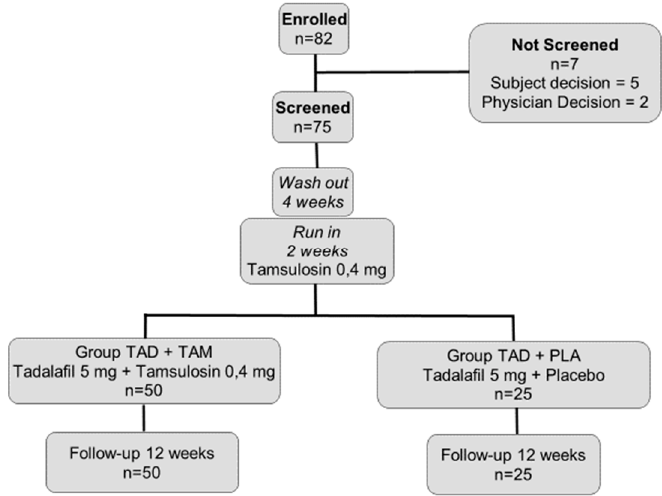
Figure 1. Disposition of subjects according to Subject Consolidated Standards of Reporting Trials (CONSORT) diagram.